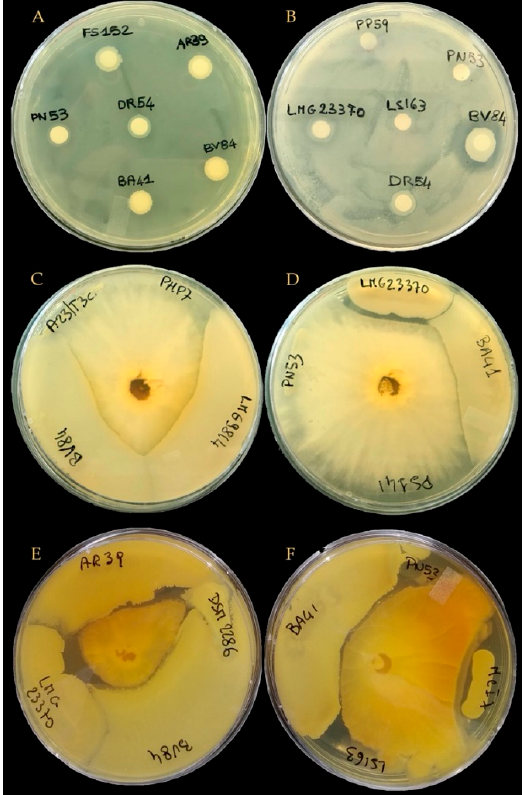
Figure 2. Examples of the in vitro microbial interactions. ( A ) Test strain B. ambifaria MCI 7: compatible with B. amyloliquefaciens BA41, A. radiobacter AR39 and B. licheniformis FS152, unclear compatibility with Pseudomonas sp. PN53 and P. fluorescens DR54; ( B ) test strain B. licheniformis PS141: compatible with K. pastoris PP59, Pseudomonas sp. PN53, A. chroococcum LS163, and B. subtilis LMG 23370, incompatible with Bacillus sp. BV84; ( C ) test strain T. harzianum TH01: compatible with P. granadensis A23/T3c and B. ambifaria PHP7, incompatible with Bacillus sp. BV84 and B. amyloliquefaciens LMG 9814; ( D ) test strain: T. harzianum TH01: compatible with P. fluorescens PN53 and B. licheniformis PS141, incompatible with B. subtilis LMG 23370 and B. amyloliquefaciens BA41; ( E , F ) test strain: T. harzianum ATCC 48131: incompatible with A. radiobacter AR39, A. chroococcum DSM 2286, B. subtilis LMG 23370, Bacillus sp. BV84, B. amyloliquefaciens BA41, B. ambifaria MCI 7, Pseudomonas sp. PN53, and A. chroococcum